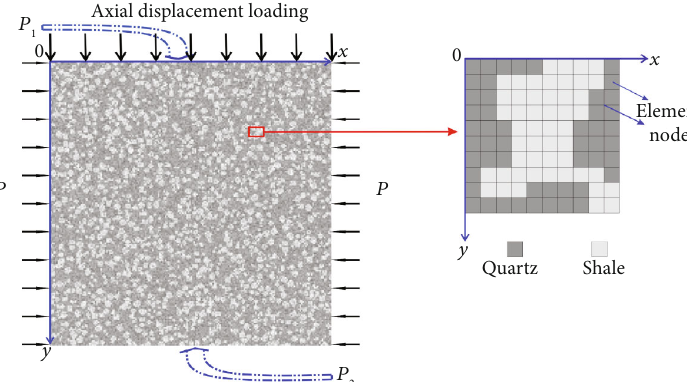
Figure 11: Schematic diagram of stress loading and grid element division.